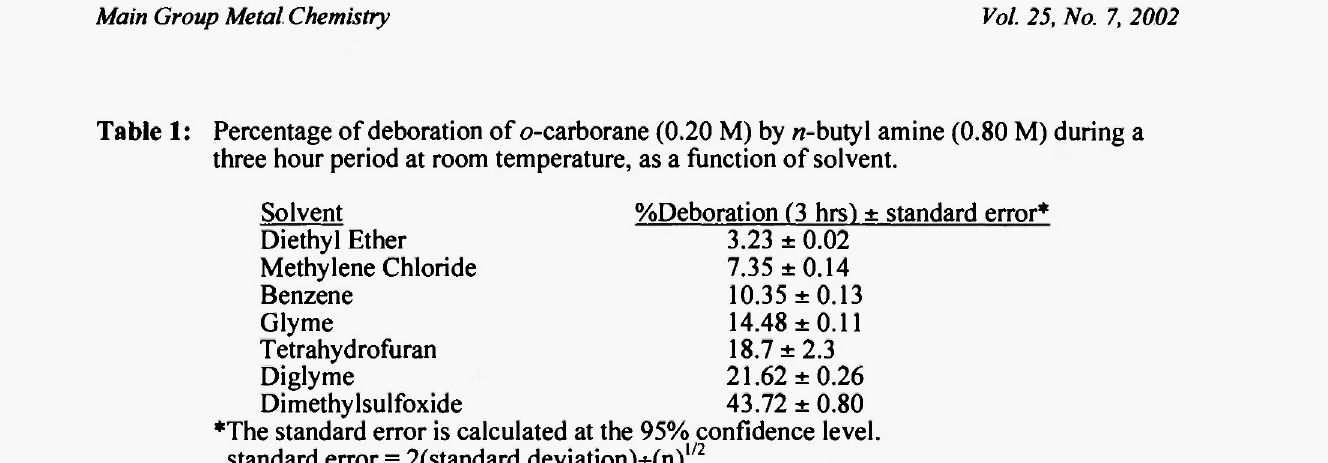
Table 1: Percentage of deboration of o-carborane (0.20 M) by «-butyl amine (0.80 M) during a three hour period at room temperature, as a function of